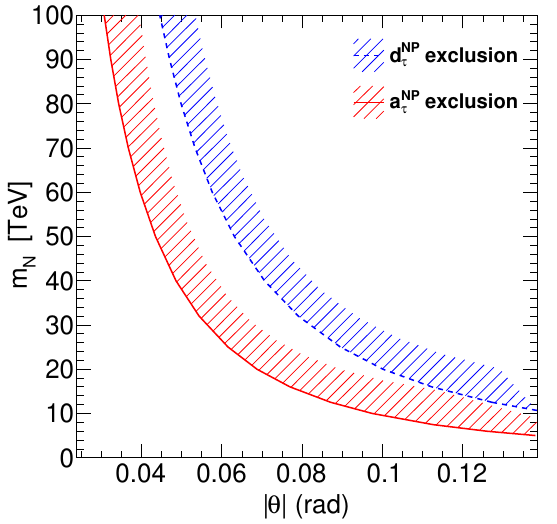
Figure 10 . The 95% exclusion of a mirror neutrino model in the mixing angle- m N plane, for both tau EDM ((cid:1) (cid:31) = (cid:25)= 2) and g -2 ((cid:1) (cid:31) =